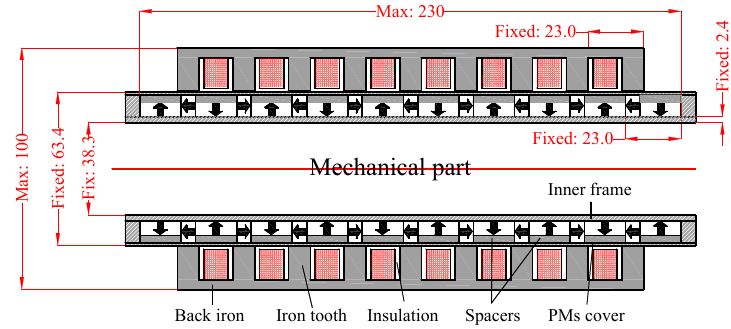
Figure 6. General dimensions of the 8-slot 8-pole machine (mm) [10].